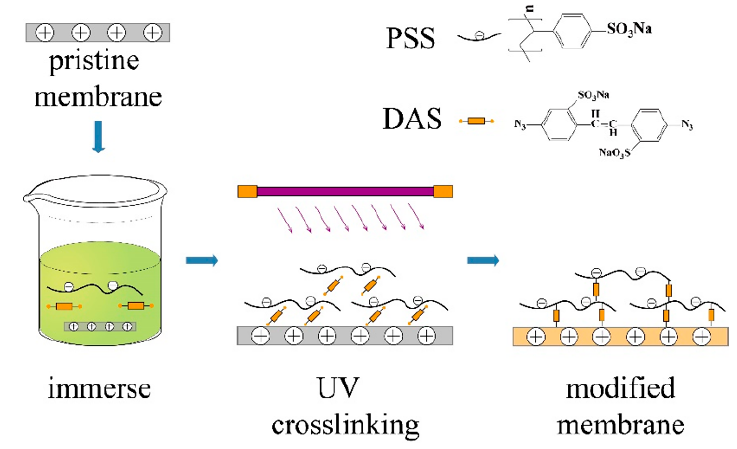
Figure 1. Diagram of the membrane modification process.